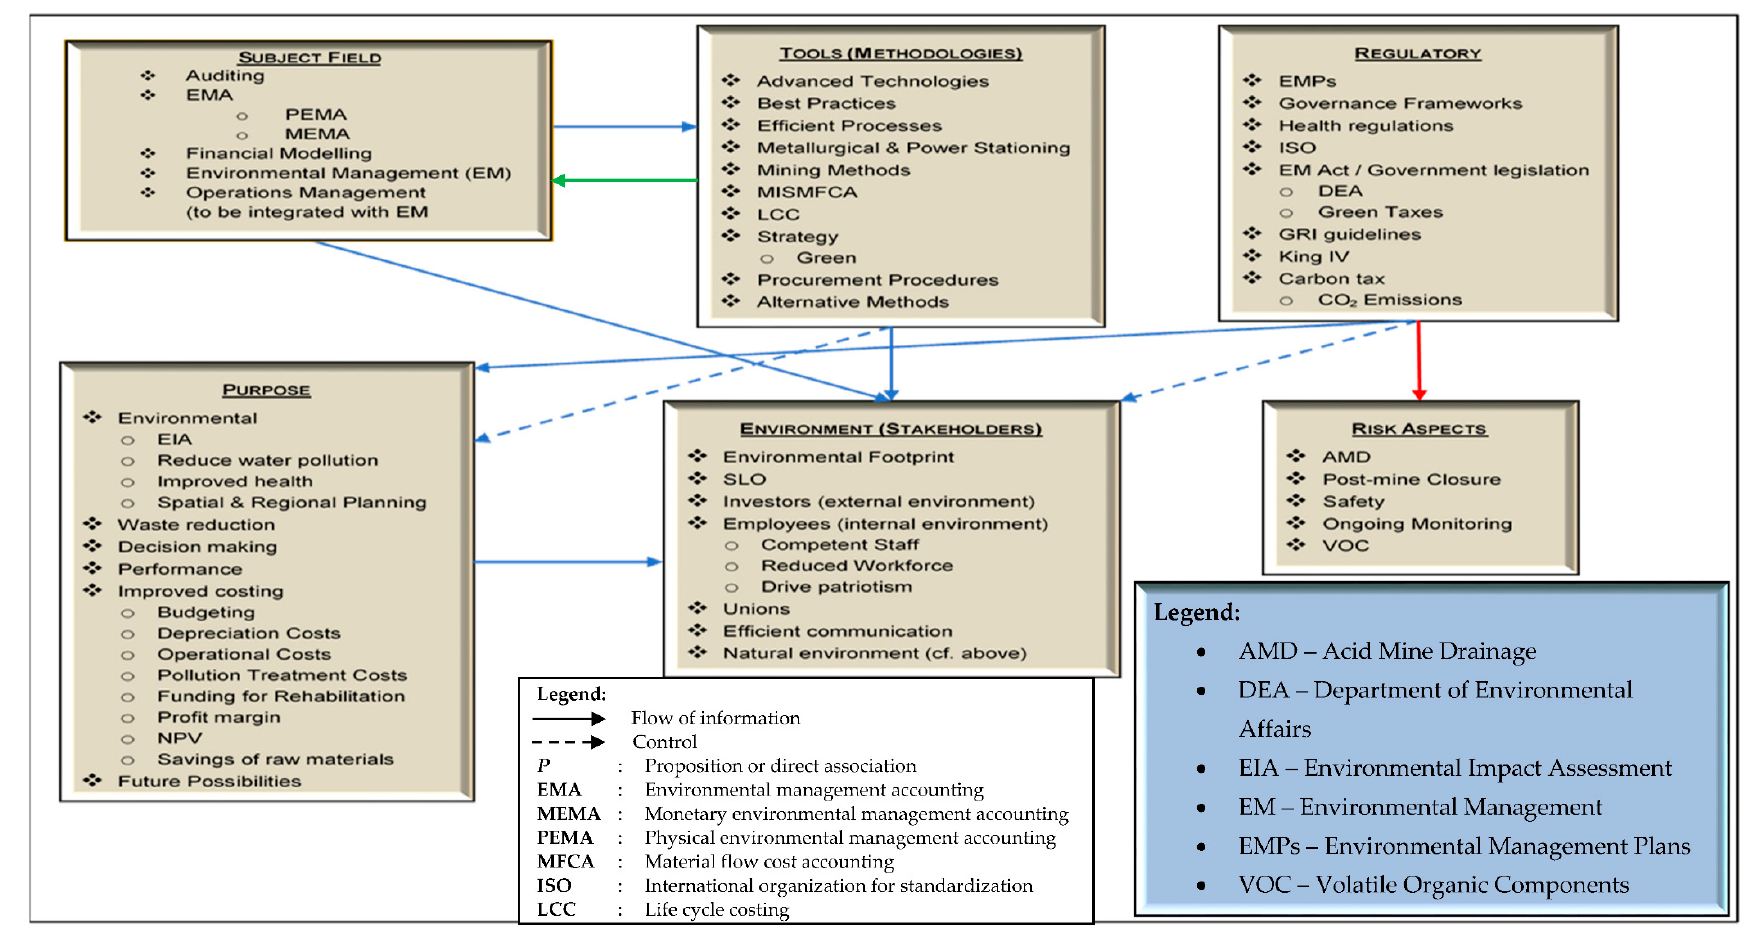
Figure 3. Final decision-making framework for South African coalmining companies.